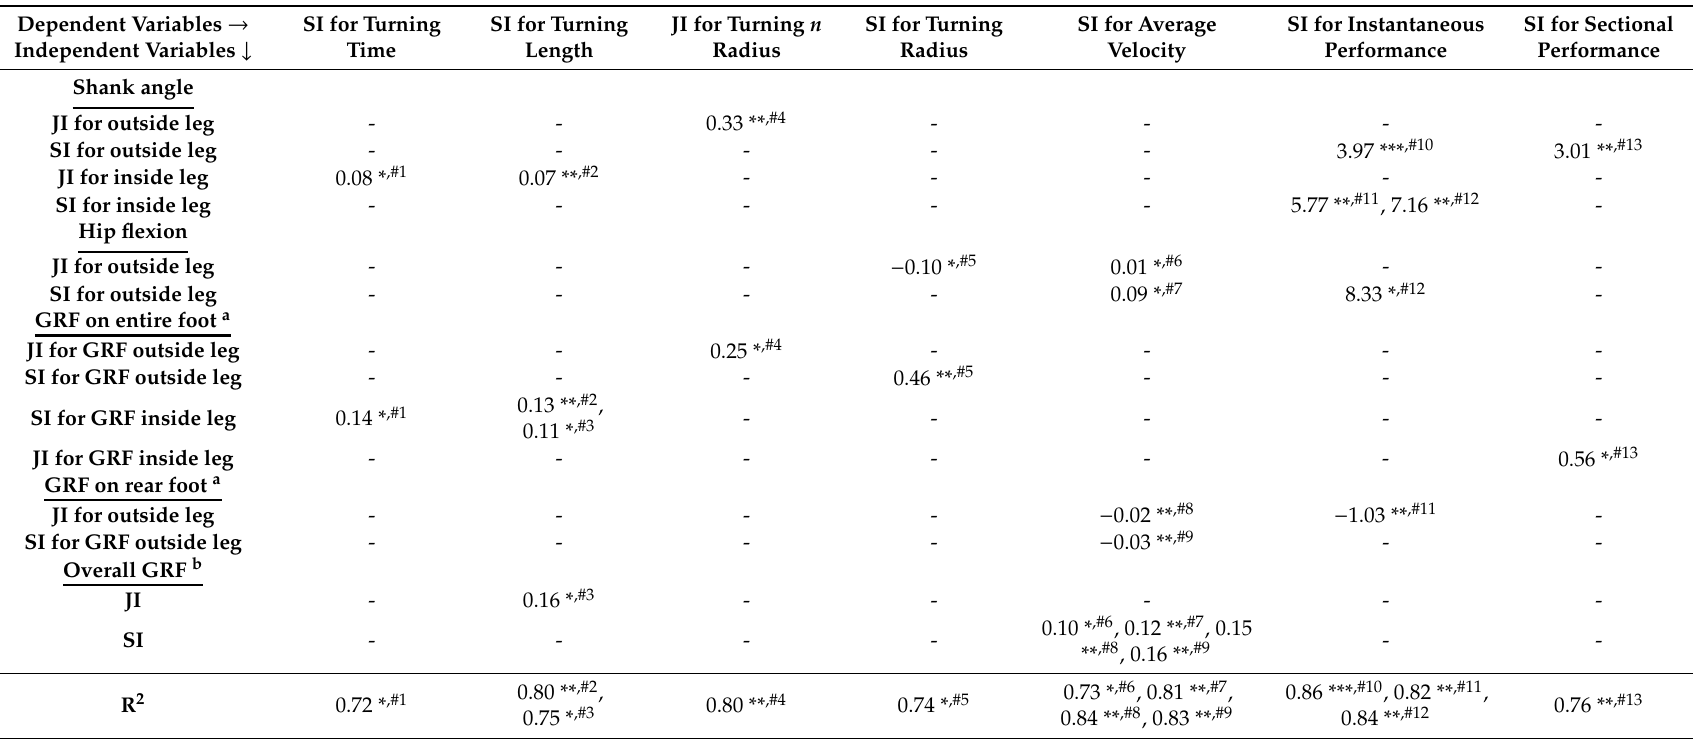
Table 3. Multivariable linear regression analysis of the relationships between the predicted (dependent, columns) and predictor (independent, rows) variables. The values in each column represent the coe ffi cients of predictor